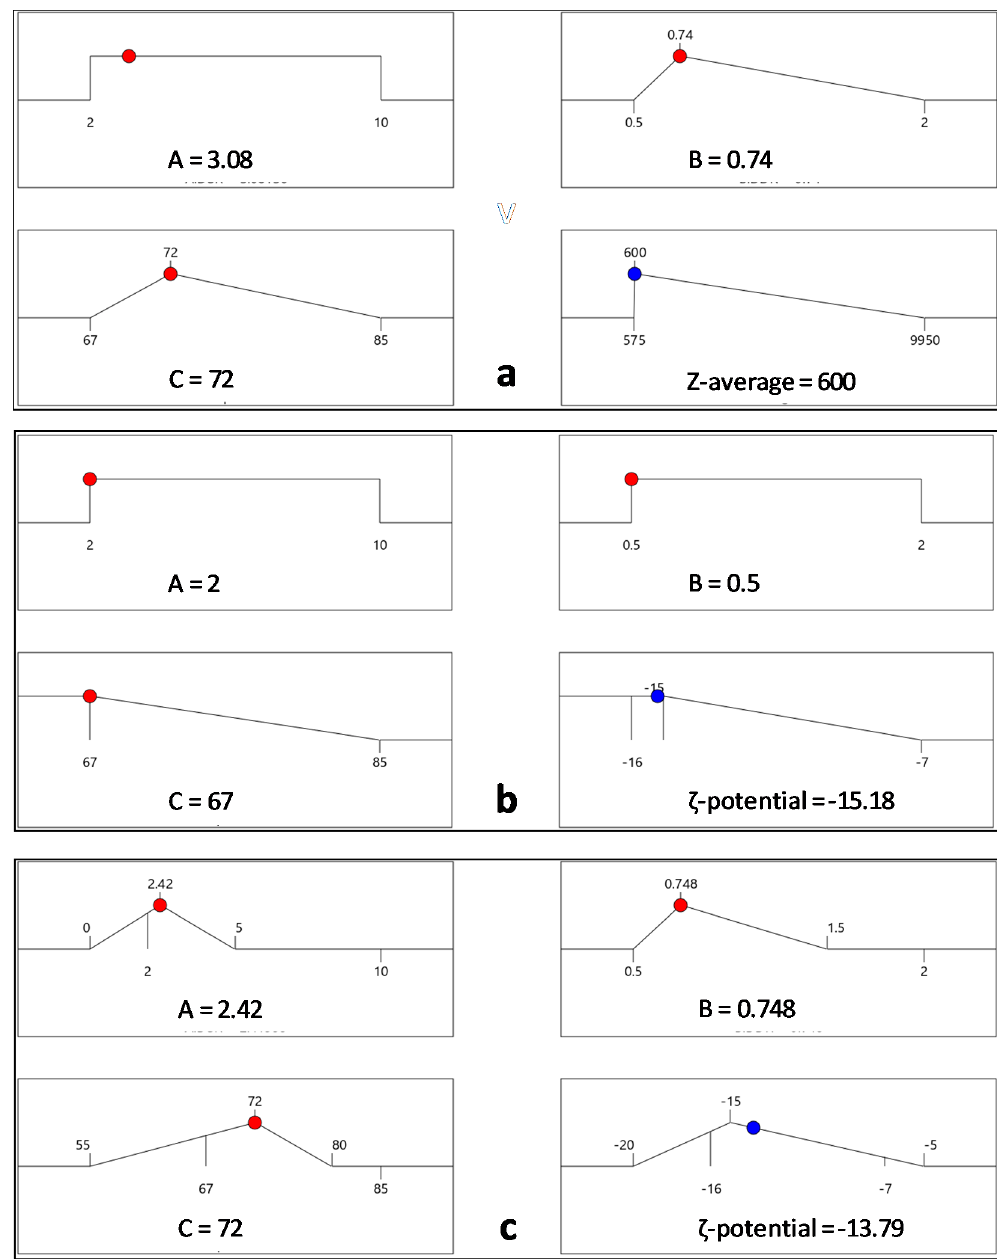
Figure 6. Numerical optimization ramps showing the optimal solution that meets the criteria of desired CQAs. The optimal factor settings of inlet temperature, drug-stabilizer and drug-mannitol ratios are shown with red dots, while the optimal response prediction values are displayed in blue: ( a ) Average particle size set minimum at 600 nm; ( b ) algebraic corresponding ζ -potential at − 15,187 mV and set minimum inlet temperature corresponding to 67 ◦ C; and ( c ) the combined optimal response prediction of A and B according to the QbD iterated standards.